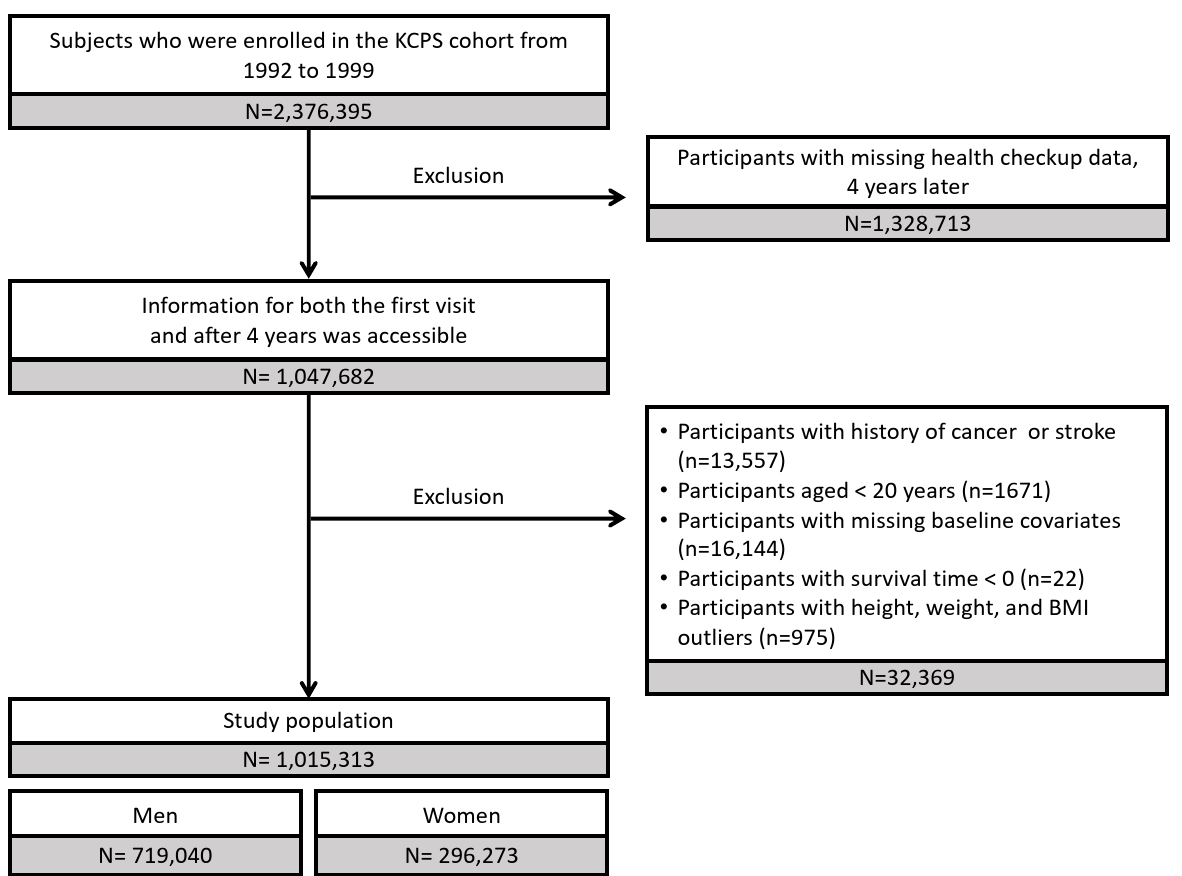
Figure 1. Flow chart of the study population. KCPS, Korean Cancer Prevention Study.